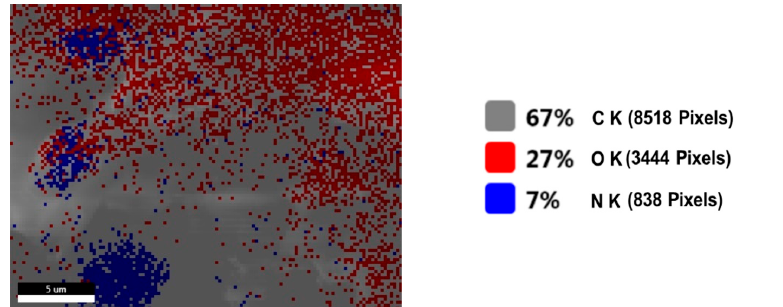
Figure 9. Engineered viscum–AuNPs carrier assembly: SEM—live map.